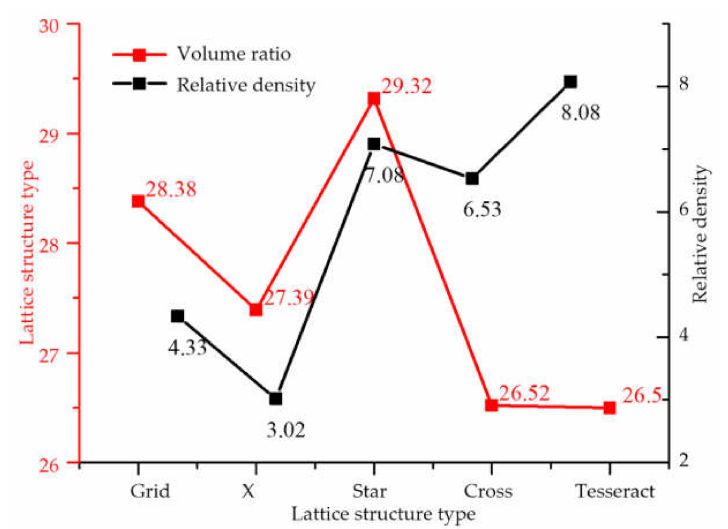
Figure 8. Relative density and the proportion of the volume of the heated